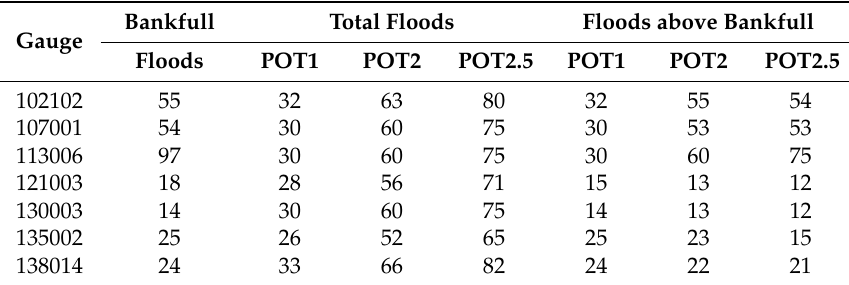
Table 4. Number of floods produced by three different POT series compared to BF floods for the selected catchments across the GBR lagoon.